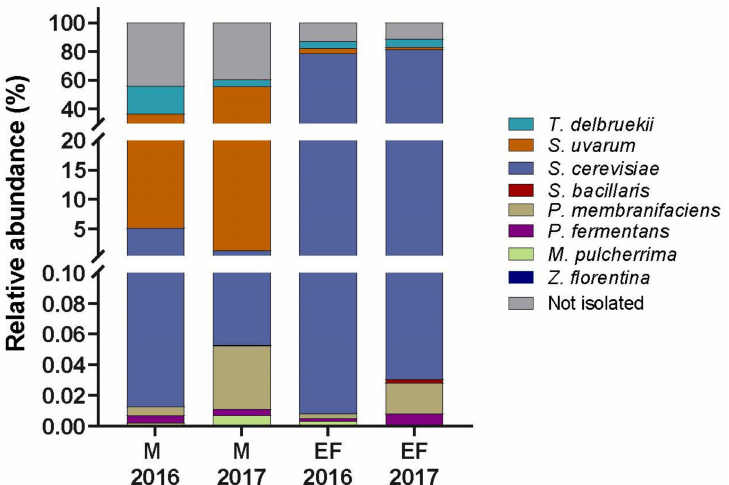
Figure 2. Relative abundance of isolates in unfermented and end of fermentation stages. Reads from high-throughput sequencing (HTS) were mapped to the internal transcribed spacer (ITS) sequences of isolates to calculate the average relative abundances of isolated species from unfermented (M) and end of fermentation (EF) samples. In grey, relative abundance of the remaining species that were not isolated but were massive